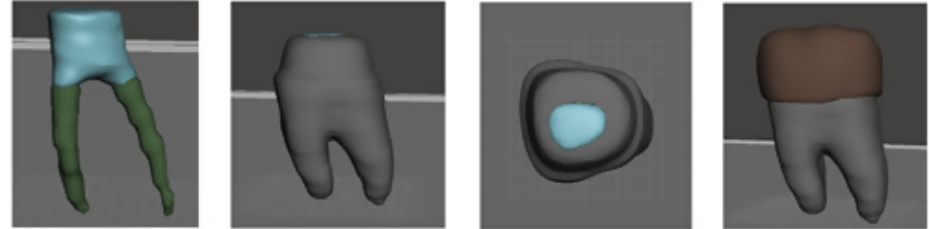
Figure 4. STL files: Core (blue), gutta percha (green), tooth structure (gray) and crown (brown).